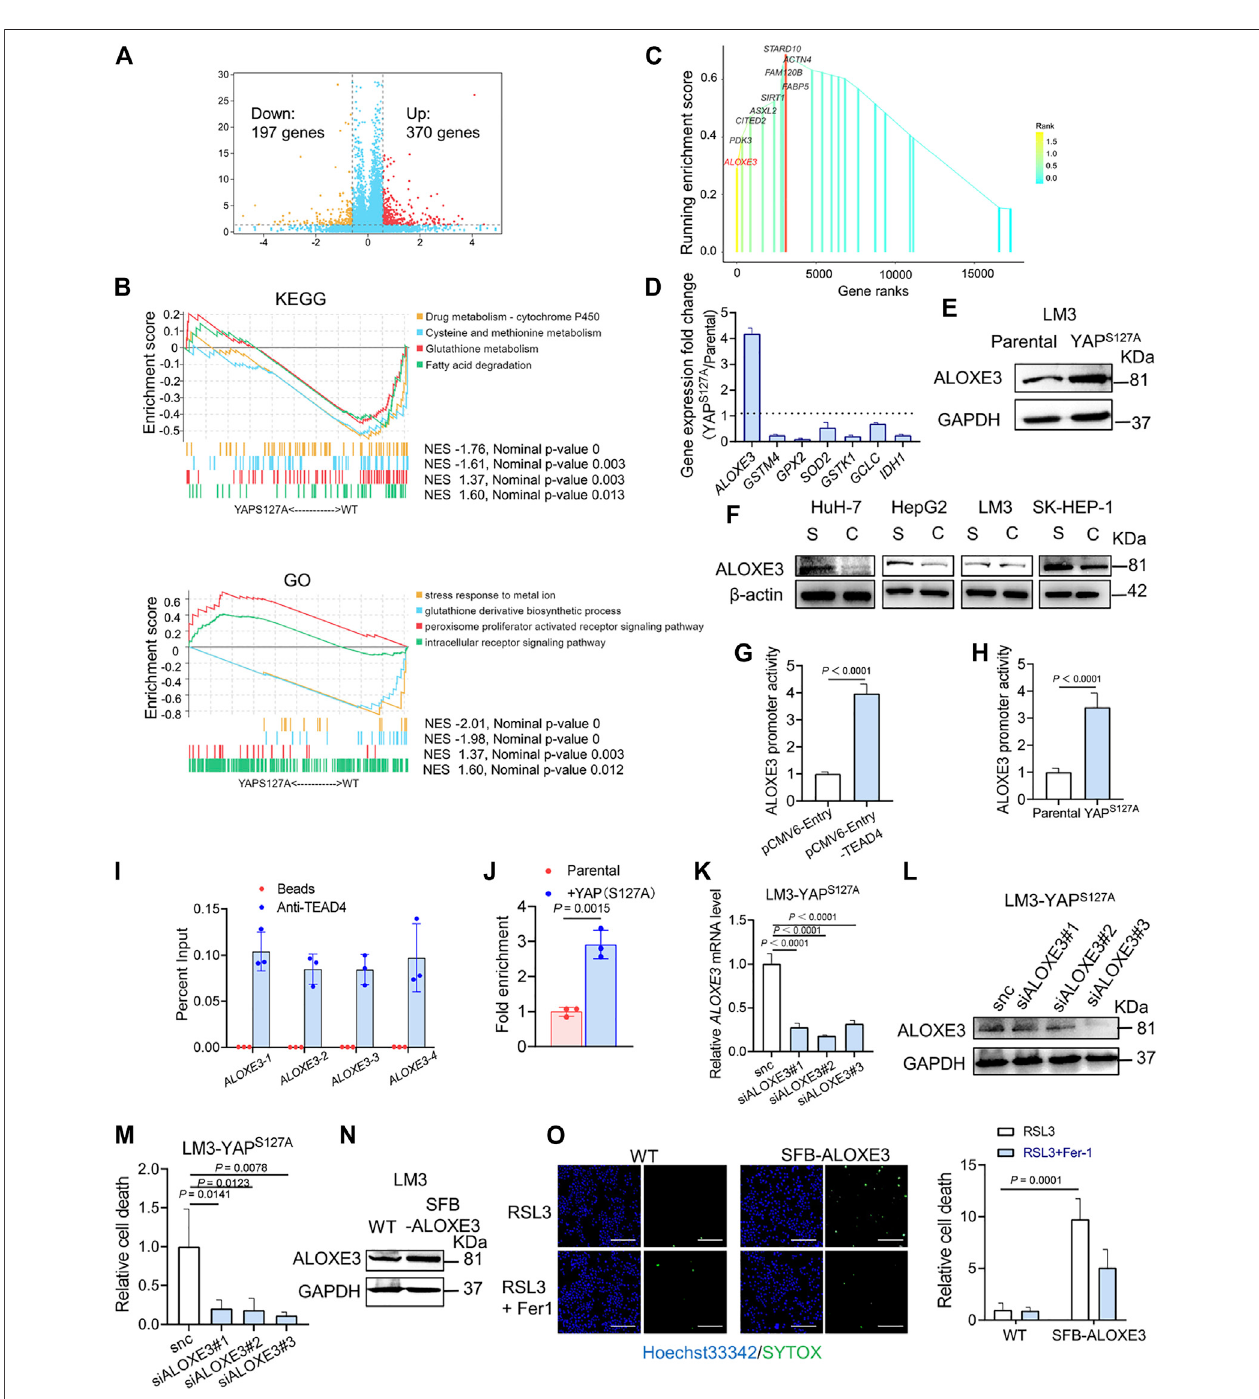
FIGURE 6 | ALOXE3 in regulating YAP-mediated ferroptosis in human HCC cell lines. (A) YAP S127A mutant and parental LM3 cells were analyzed by RNA sequencing. Identi fi cation of differentially expressed genes is illustrated in a volcano plot. (B) GSEA enrichment plot showing the enrichment of genes associated with pathways involved in ferroptosis. (C) Genes comprising the leading edge of Enrichment score in the category of peroxisome proliferator activated receptor signaling pathway inYAP S127A -overexpressingcells. (D) Relative expression ofthe genesassociated withferroptosis regulation. n (cid:2) 3biologicallyindependent samplesper condition. (E) The expression of ALOXE3 in YAP S127A -overexpressing and parental LM3 cells was tested by western blot. (F) The expression of ALOXE3 in sparse and con fl uent HCC cells. S, sparse. C, con fl uent. (G) A dual-luciferase reporter assay was performed in LM3 cells, which were co-transfected with ALOXE3 promoter (pGL- ALOXE3)andTEADplasmid(pCMV-Entry-TEAD4)oremptyplasmid(pCMV-Entry). (H) Adual-luciferasereporterassaywasperformedinYAP S127A -overexpressingand parental LM3 cells, which were transfected with ALOXE3 promoter (pGL-ALOXE3). n (cid:2) 3 biologically independent samples per condition. (I) ChIP analysis of TEAD4